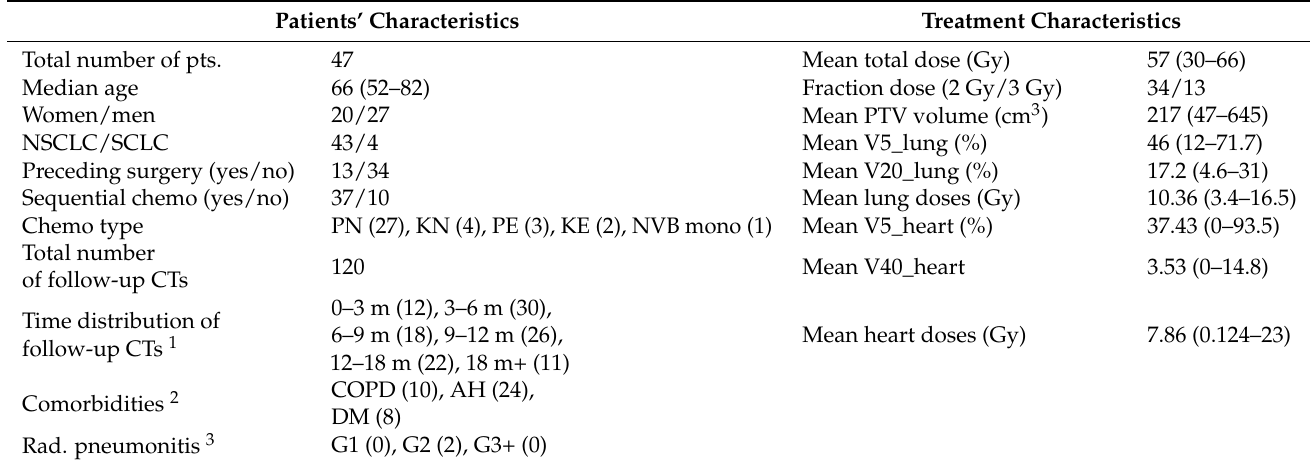
Table 1. Patients’ and treatment